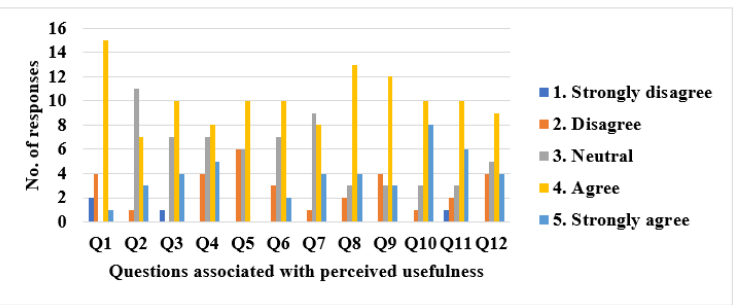
Figure 5. Number of responses for items related to